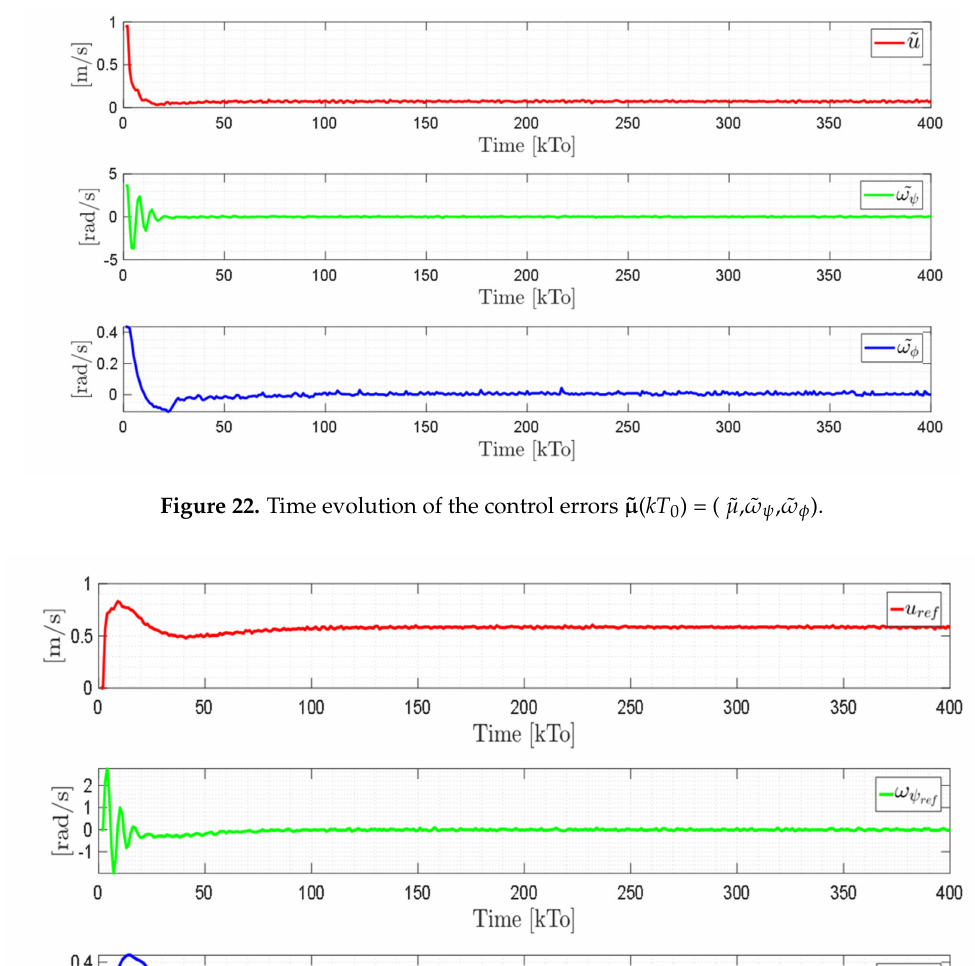
, ω φ ). ref ref ~ (cid:1) ∈ η (cid:0) (cid:101) η x , (cid:101) η y , (cid:101) η z , (cid:101) η R 4 ψ